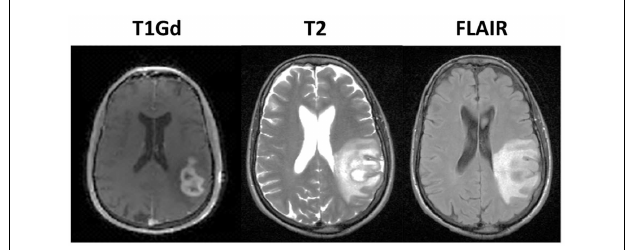
FIGURE 1 | Illustration of primary imaging modalities. TheT1Gd image will show enhancement where the contrast agent has been able to diffuse into the extracellular space where the blood brain barrier has been compromised due to tumor-induced neo-angiogenesis.TheT2-weighted and FLAIR images are associated with edema or swelling; FLAIR is different fromT2 in that the signal from the cerebral spinal fluid (CSF) is removed. In the case of GBM, the non-CSFT2/FLAIR enhancement is primarily vasogenic edema, defined as fluid originating from blood vessels that accumulates around cells (Marmarou, 2007).The fluid leaves the vessels due to pressure and osmotic gradients induced by the breakdown in the blood brain